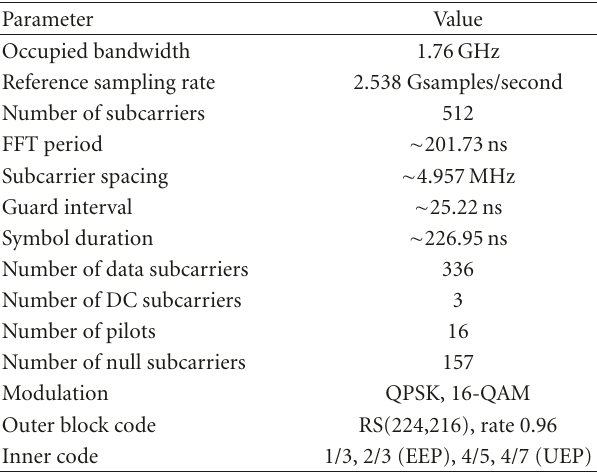
Table 1: WirelessHD specification parameters